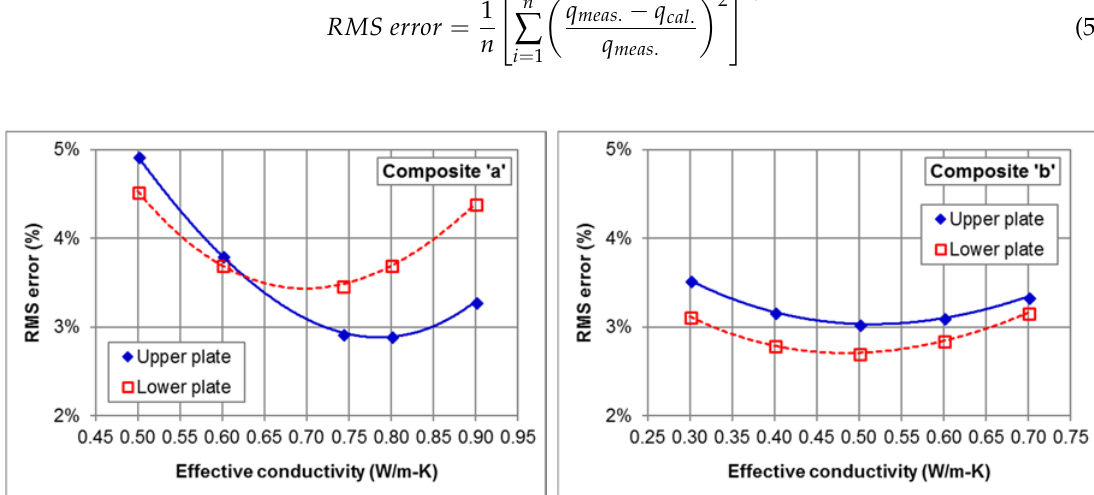
Figure 11. Root mean square errors between the calculated and measured heat fluxes.